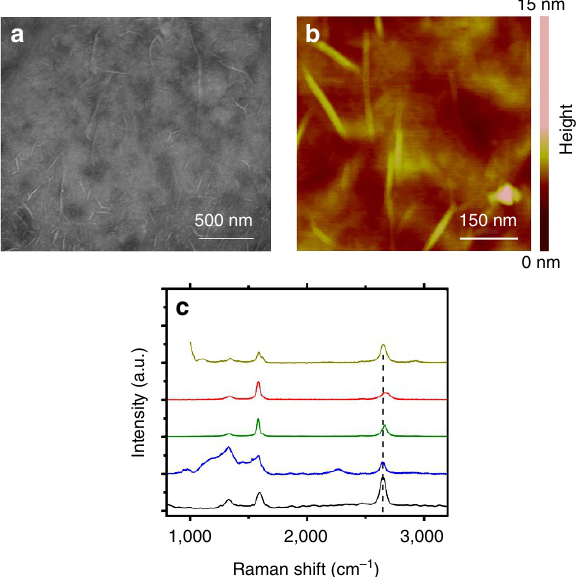
Figure 3 | Characterization of graphene on UNCD sample. ( a ) The SEM and ( b ) AFM images of grown graphene indicate the formation of the continuous uniform film with occasional folds occurring; ( c ) Raman signature of graphene films produced at different temperatures indicates the variation in the number of grown layers (green line highlighting single layer grown at 800 (cid:2) C and red line highlighting multilayer grown at 1,000 (cid:2) C). The Raman signature of graphene grown at 800 (cid:2) C and then thermal-release tape transferred onto silicon dioxide substrate (dark yellow) confirms the single-layer thickness of graphene. The Raman spectra of single-layer graphene grown on copper (black line) and then transferred on the UNCD film (blue line) are provided for reference. Dashed line highlights the position of 2D peak.